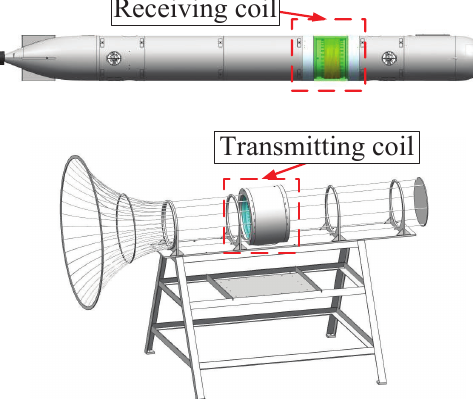
Figure 1. A typical wireless charging mode for